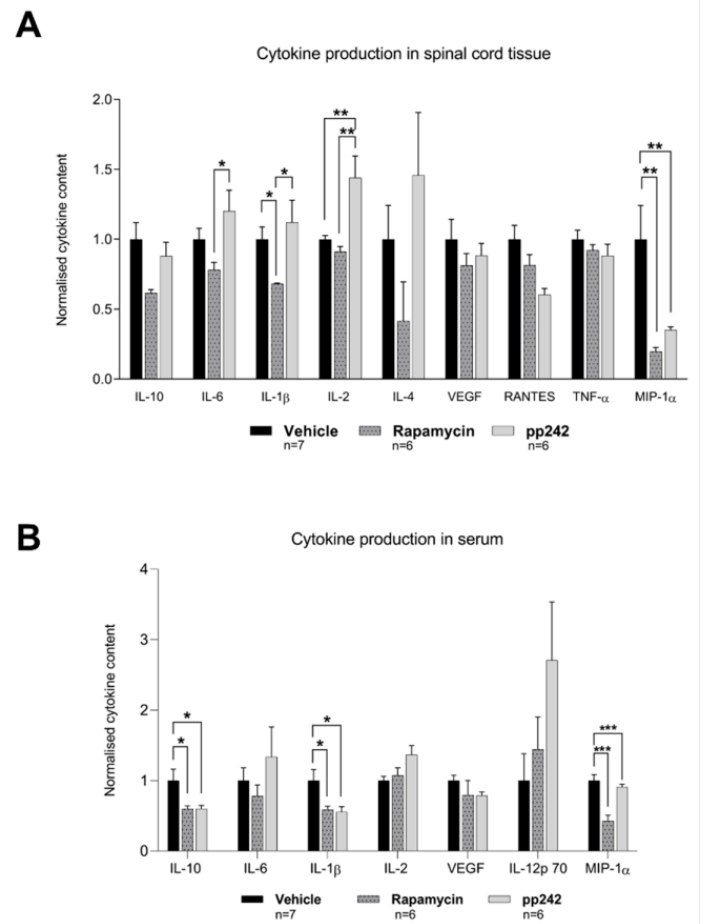
Figure 3. Suppression of mTOR pathway by RAPA or pp242 alters cytokine production in SCI. Analysis of cytokine levels in spinal cord tissue ( A ) and serum ( B ) after SCI. Calculated concentration data were normalized to the average concentration of the vehicle control group for each